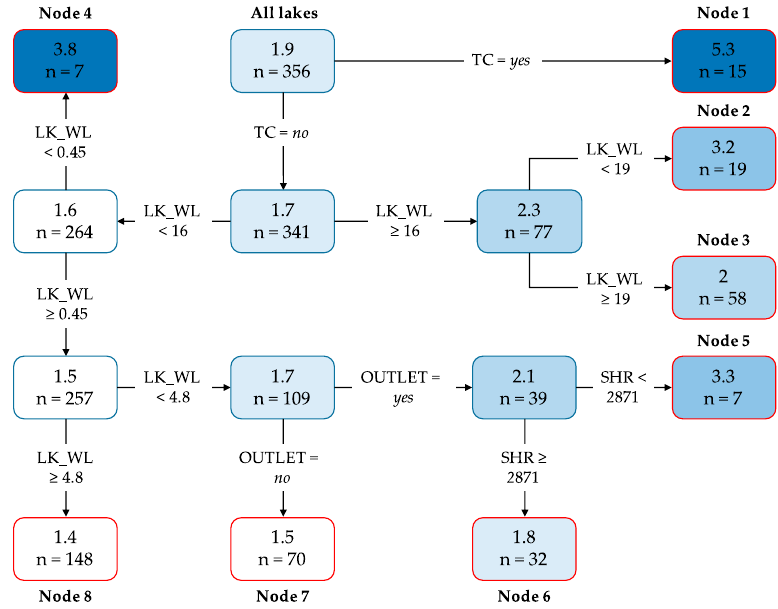
Figure 4. Regression tree explaining the environmental drivers of CDOM in Central Yamal lakes. The tree contains seven splits (boxes with a blue outline) and eight terminal nodes (boxes with red outline) and shows the mean values of a(440) CDOM before splitting (upper value in the boxes), the lower value describes the number of cases in each node before splitting (356 cases = 100%). Text between boxes reflects the environmental driver (Table 3) and a threshold value. Codes are given in Table 3. Bold text reflects the number of terminal node. Color of boxes represents the mean value of a(440) CDOM within splits and terminal nodes.